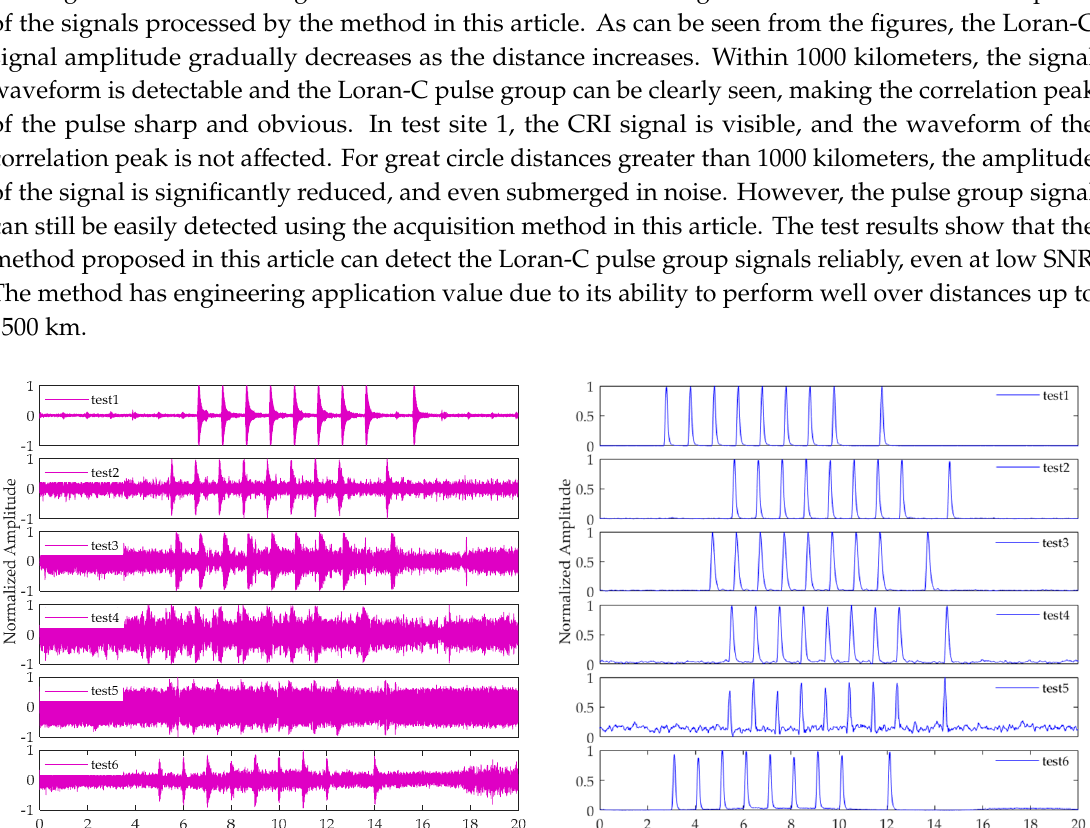
( b ) Figure 15. Test results of existing methods with respect to actual data: ( a ) the matched filter method based on Loran-C pulses signal [13]; ( b ) the delay correlation acquisition method based on Loran-C pulses signal [16].